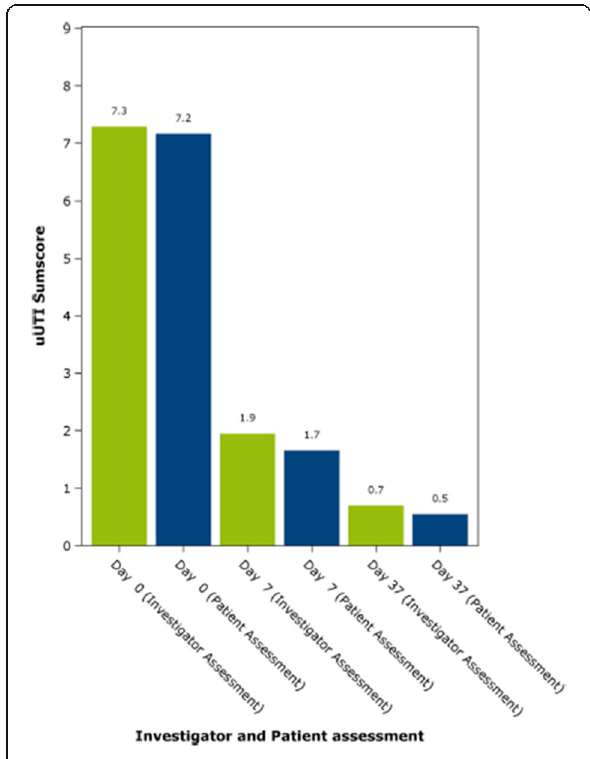
Fig. 1 Reduction of symptoms in female patients with acute uncomplicated cystitis (uUTI) treated with the phytodrug CLR for 7 days as assessed by patients and investigators [11]. The uUTI Sumscore includes the symptoms dysuria, frequency and urgency; uUTI Sumscore was assessed on Day 0, Day 7 and Day 37 (full analysis set, N = 125)